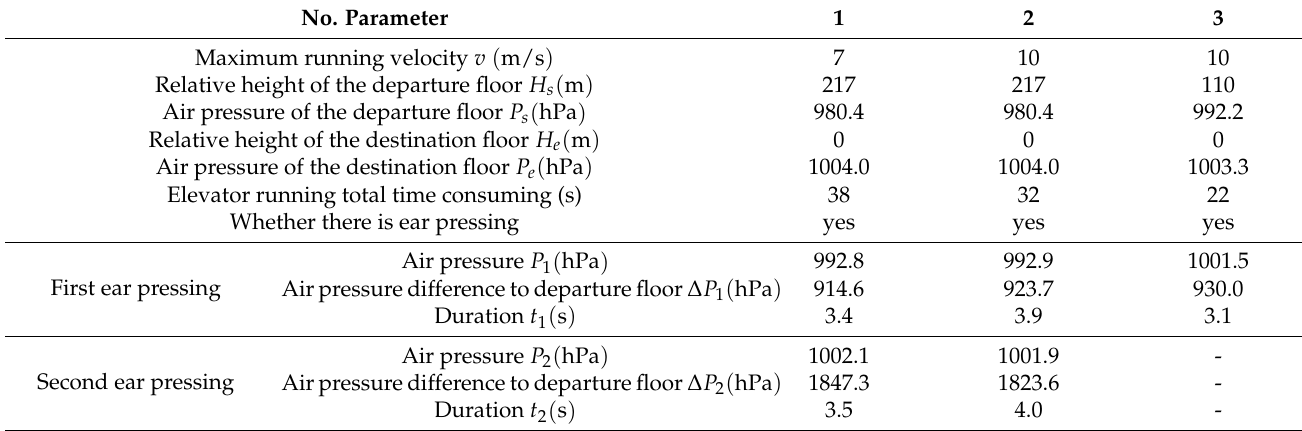
Table 2. Experimental data of air pressure change inside the